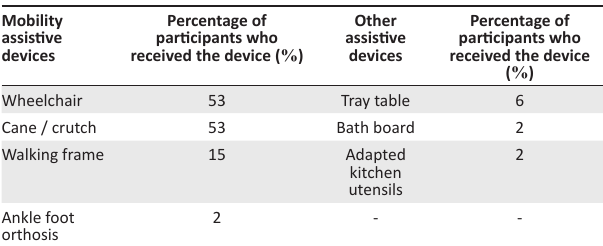
FIGURE 2: Products and technology experienced as barriers and facilitators ( n = 53). TABLE 2: Assistive devices received by participants ( n =